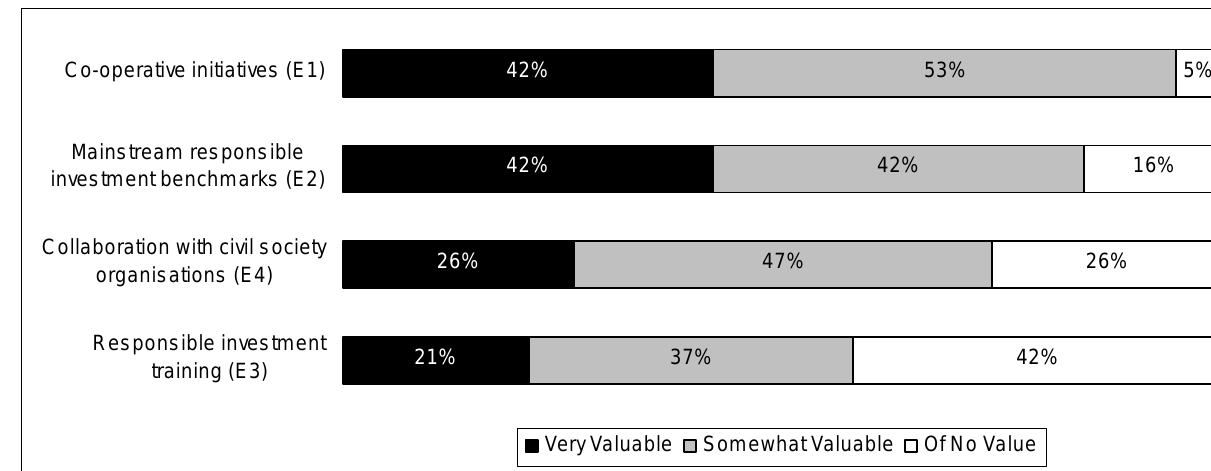
Figure 8: Asset managers - RI enablers